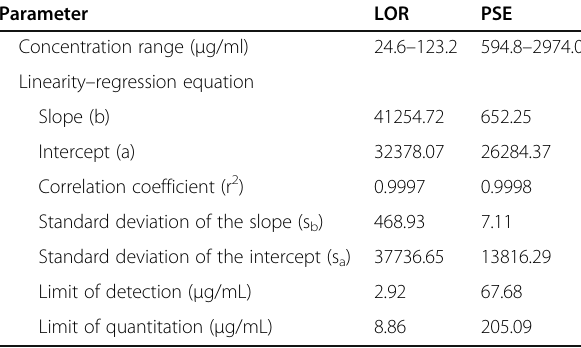
Table 2 Linearity data of the developed